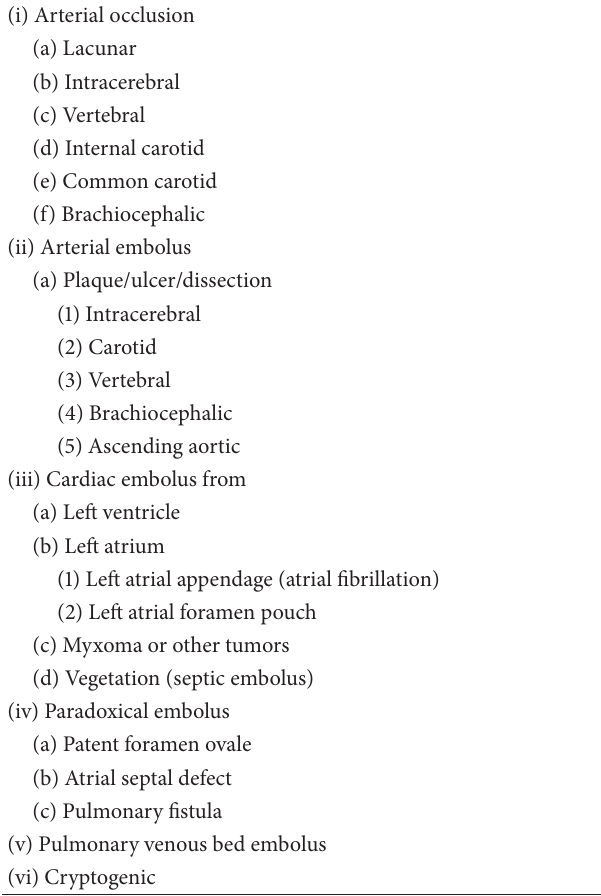
Table 2: Ischemic stroke